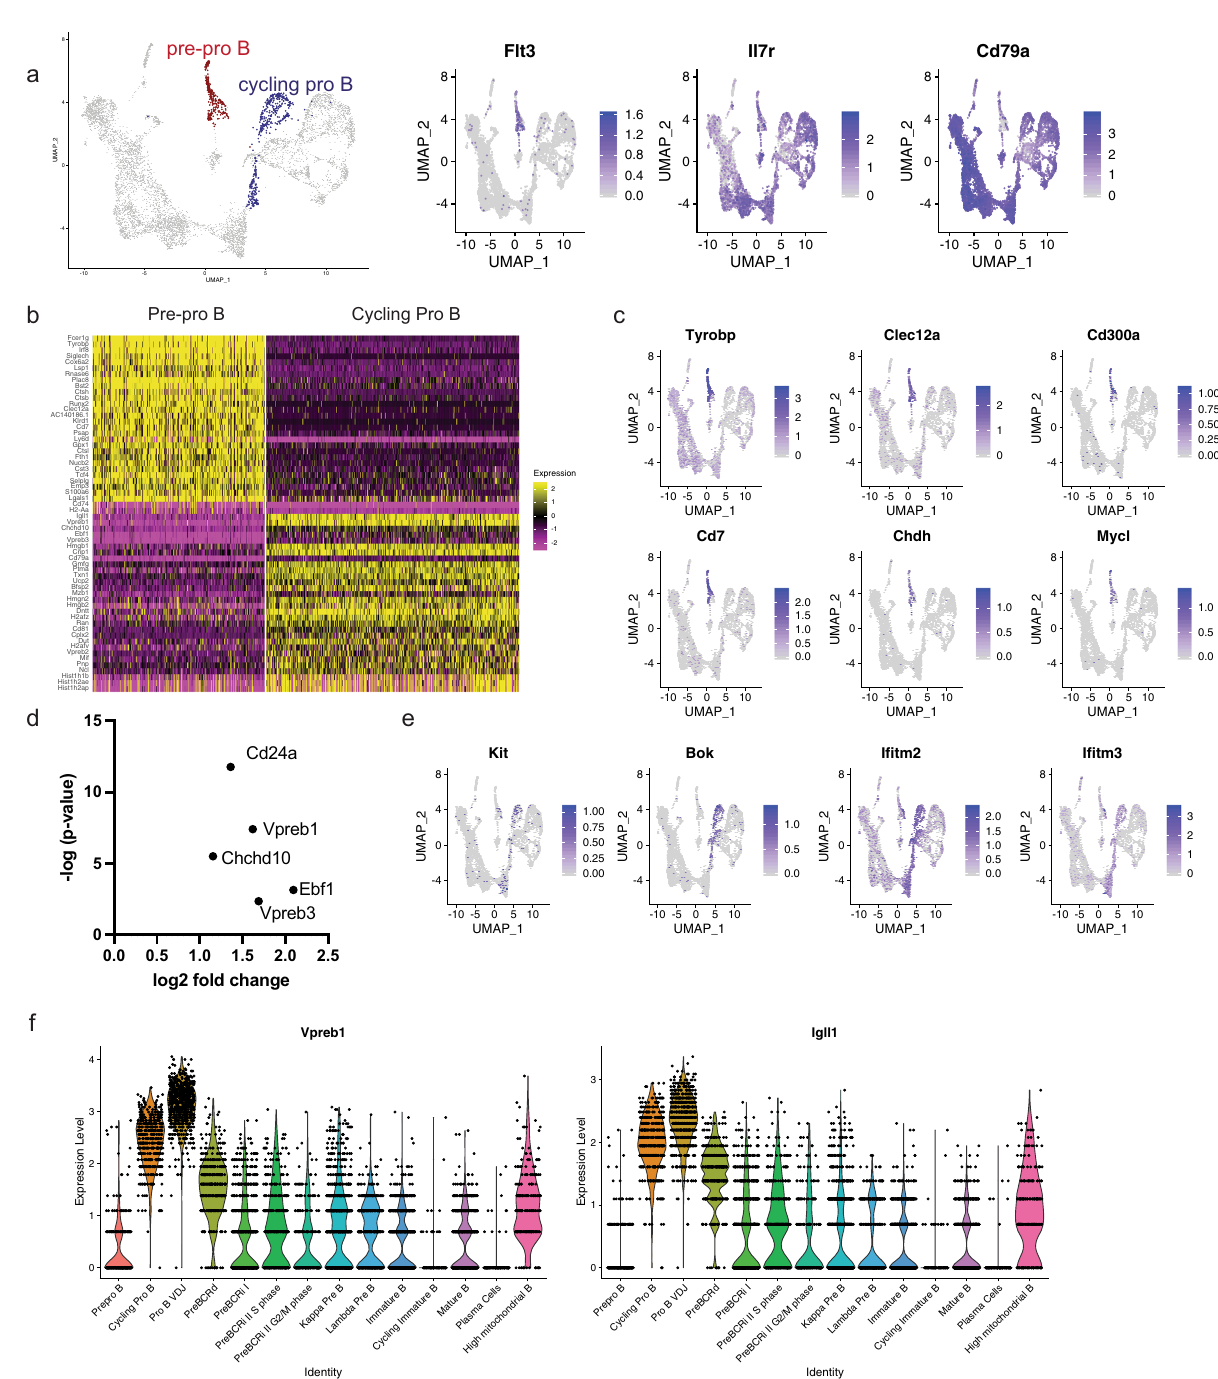
Fig. 2 Transcriptional signatures of pre – pro B cells and committed pro-B cells. a Highlighted populations for pre – pro B and cycling pro-B cells (left). Feature plots for early B-cell markers (right). b Heatmap of genes that are differentially expressed between the pre – pro B cells and the cycling pro-B cells. Scale represents normalized counts centered and scaled across cells. c Feature plot of EBF1-target genes. d Differentially upregulated genes in the CD93 ADT high versus CD93 ADT low pre – pro B-cell cluster. CD93 high versus low was based on a median split. No genes were signi fi cantly downregulated in the CD93 high population. e Feature plot of genes denoting the pro-B-cell stage ( Kit ), or genes uniquely expressed during pro-B cells. f Violin plot of the expression of surrogate light chains, Vpreb1 and Igll1 across the B-cell development stages. Color scale in a, c, e, and f represents natural log-transformed SCTransform-corrected